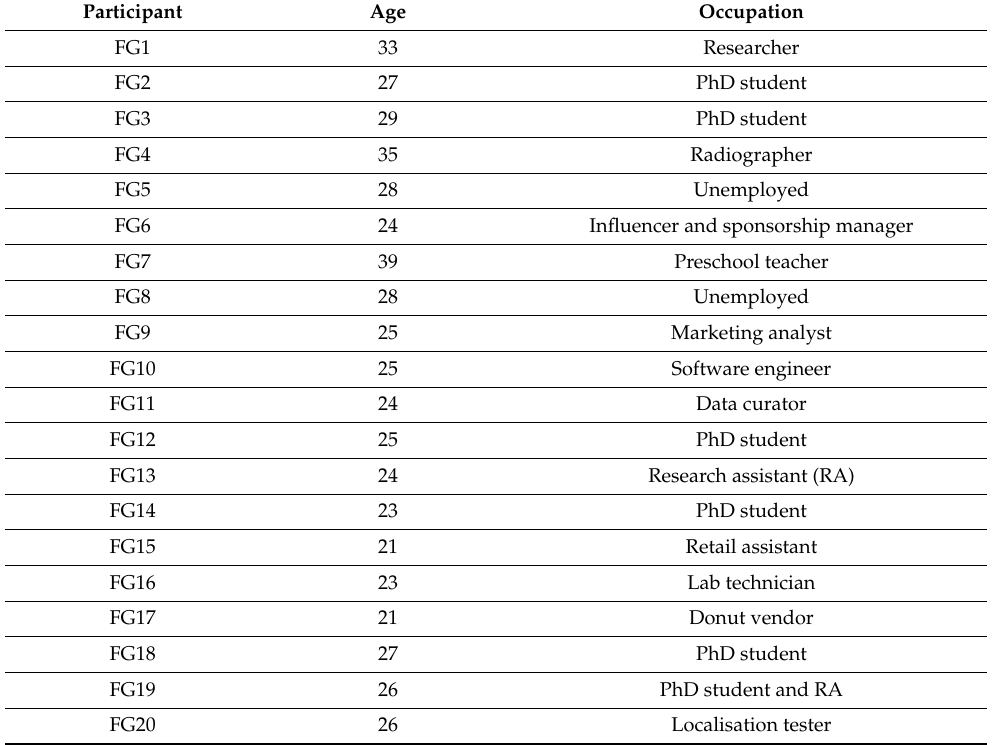
Table 1. Participant characteristics: age and